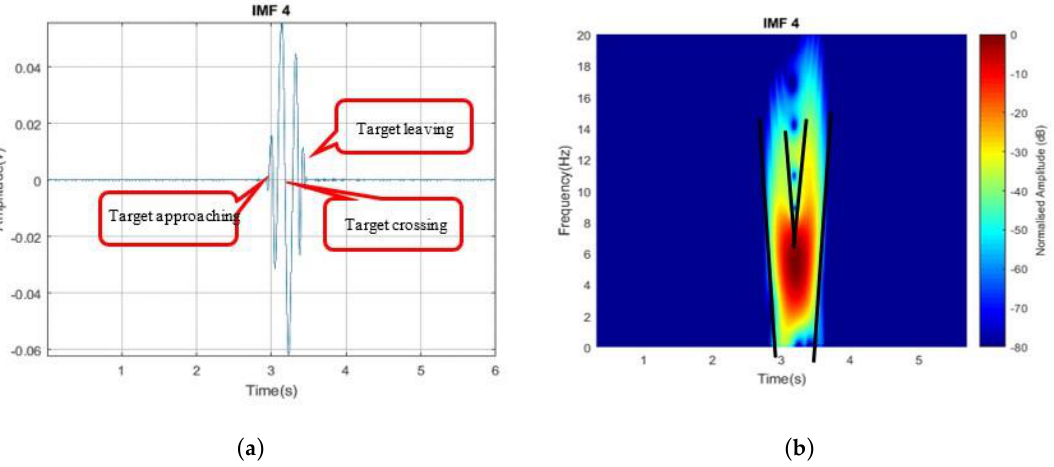
Figure 16. Extracted Doppler Component IMF4 ( a ) time domain and ( b ) its corresponding STFT plot.